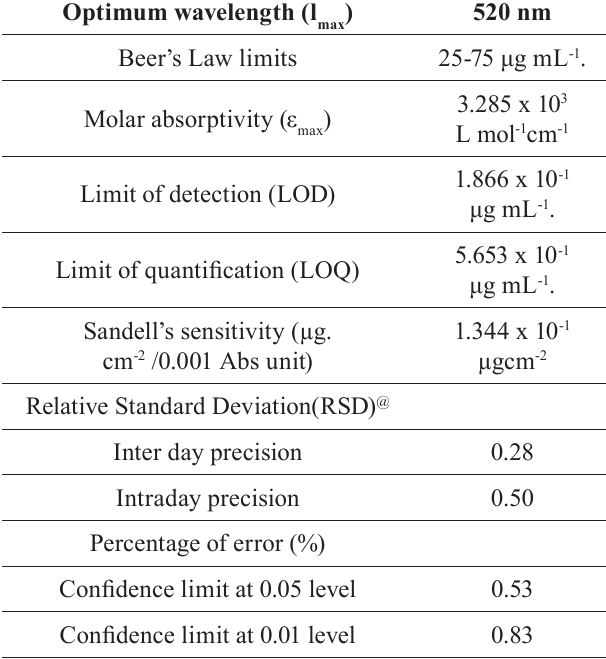
TABLE I - V alidity parameters of perindopril-DCQC